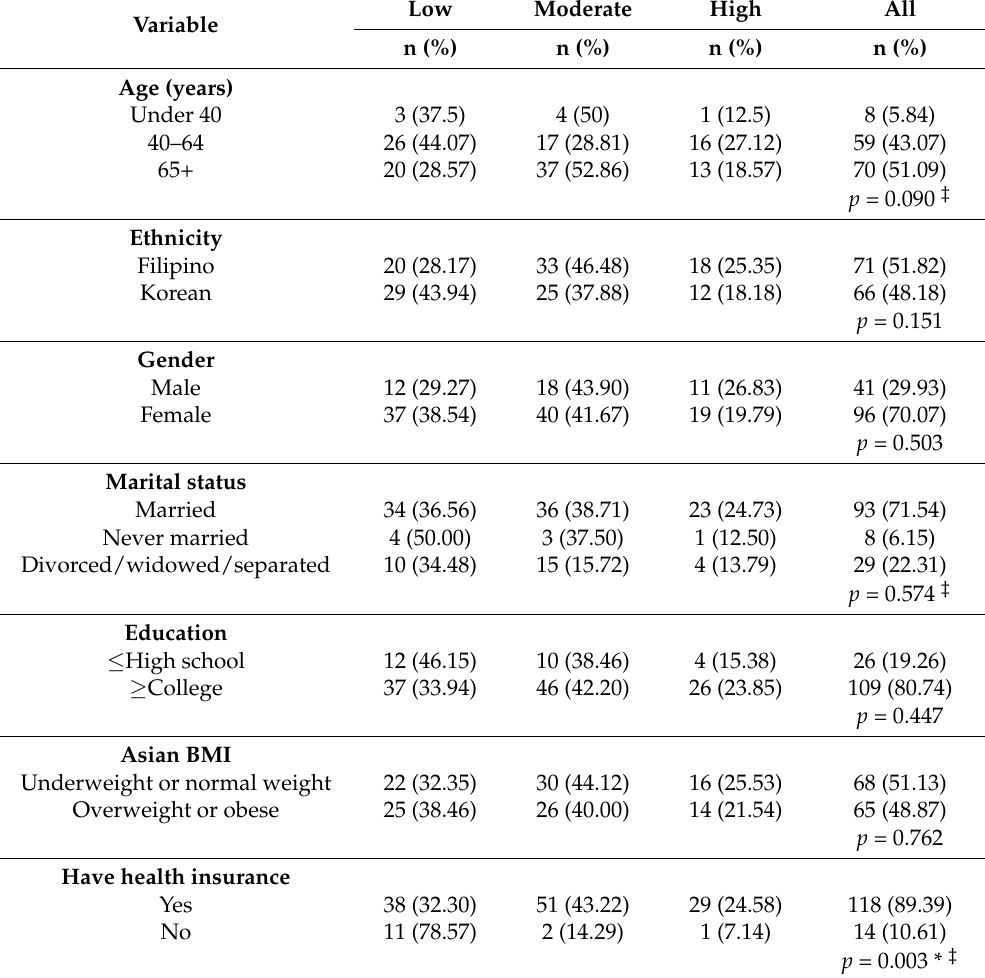
Table 3. Demographic and acculturative characteristics among all participants and by physical activity level group (n =